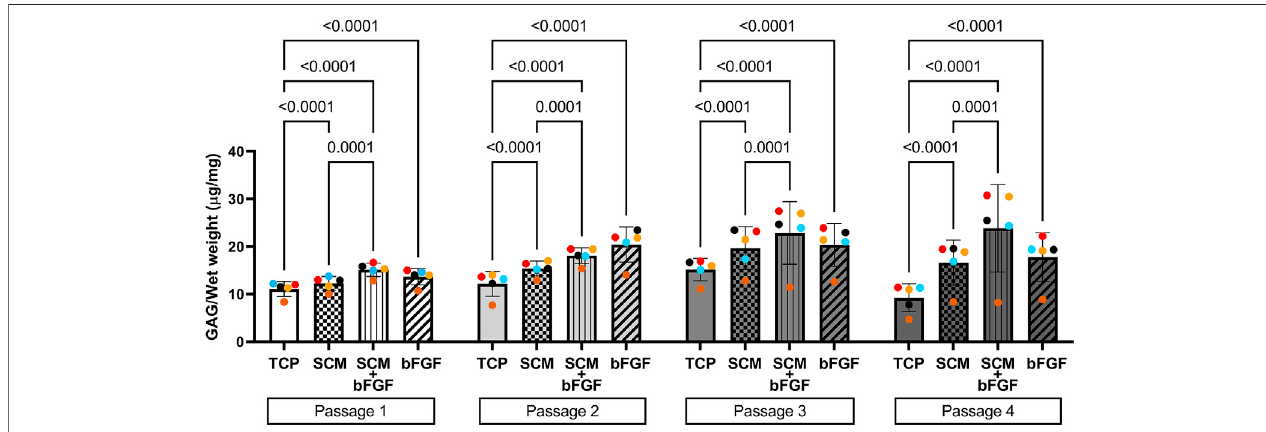
FIGURE5| Glycosaminoglycan(GAG)contentofhumancartilageaggregates.Cartilageaggregatesfrom fi vedonors(averageaggregateGAGcontentpermgwet weight, ≥ two aggregates per donor, each color represents a donor) for four passages on tissue culture plastic (TCP), synoviocyte-derived extracellular matrix (SCM), on synoviocyte matrix with bFGF (SCM + bFGF), or on tissue culture plastic with bFGF (bFGF). p < 0.05 are shown, two-way